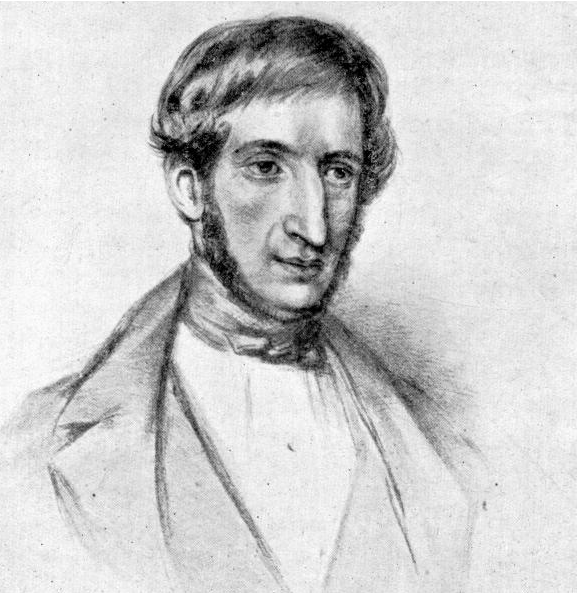
Figure 7. Carlo Matteucci [10]. Figure 8. Ottaviano Fabrizio Mossotti